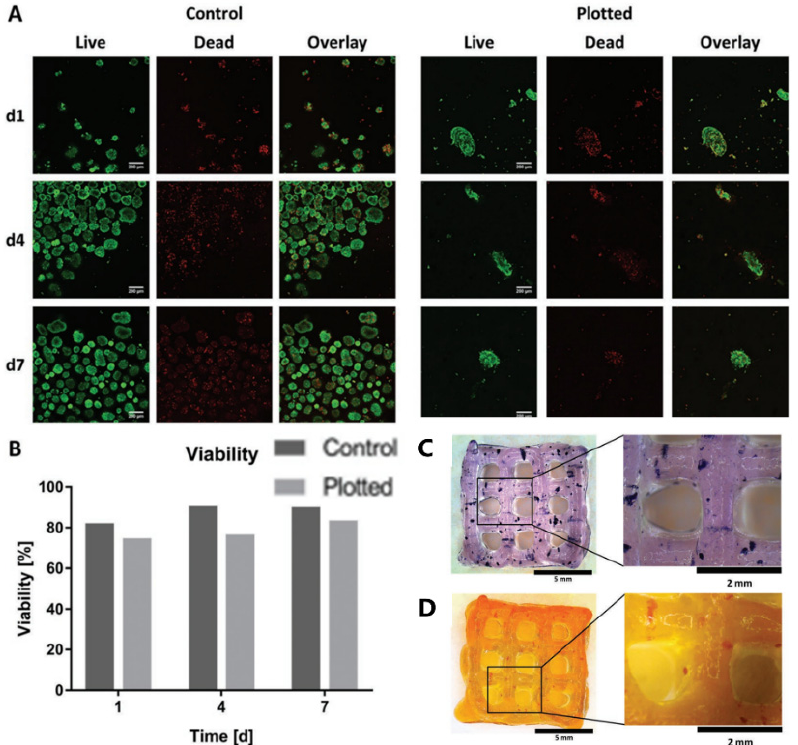
Figure 5. Islet viability assay and staining. ( A ) Live/dead staining of islets in Alg/MC gel (right) and free control islets (left). Live and dead cells are shown in green and red, respectively. ( B ) Semi- quantitative assessment of islet viability based on live/dead staining as shown in ( A ), n > 60 islets. ( C ) Islet-containing scaffolds were stained with thiazolyl blue tetrazolium bromide (MTT). ( D ) Islet- containing scaffolds were stained with dithizone (DTZ). Reprinted with permission from Ref. [76], Copyright 2019, John Wiley and Sons.